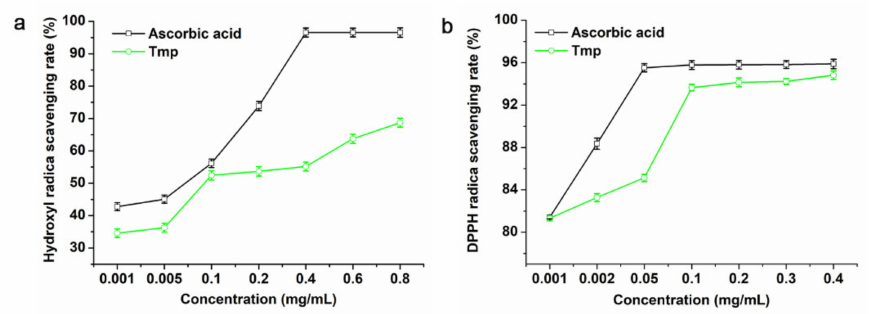
Figure 4. Scavenging activities of Tmp on hydroxyl radicals ( a ) and DPPH radicals ( b